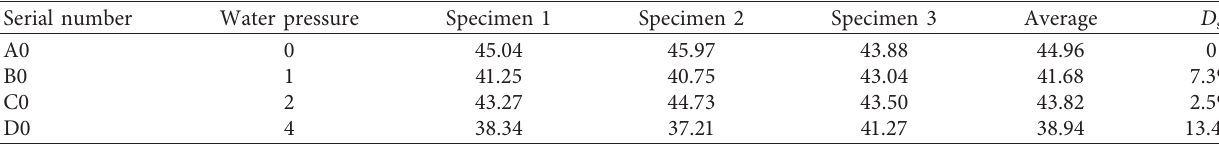
Figure 2: Failure mode of specimens under different water pressure. (a–d) Dynamic loading under 0 MPa, 1 MPa, 2 MPa, and 4 MPa water pressure; (e–h) static loading under 0 MPa, 1 MPa, 2 MPa, and 4 MPa water pressure, respectively. Table 3: Static compressive strength of concrete under different water pressure/MPa (cylindrical